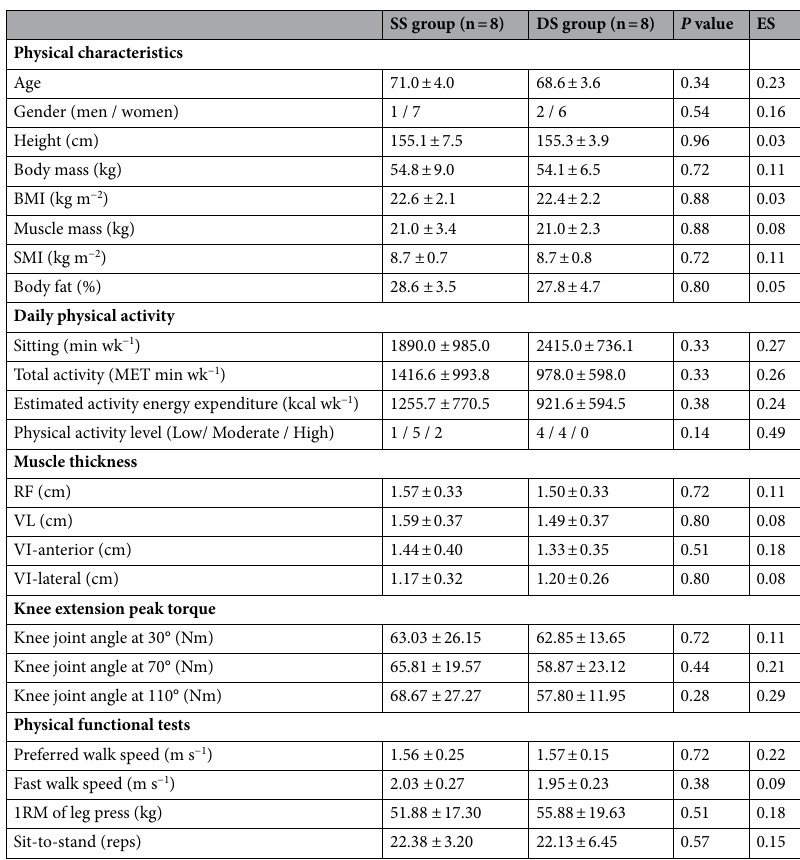
Table 1. Baseline physical characteristics parameters, daily physical activity, muscle thickness, knee extension peak torques and physical functional tests in shallow squat (SS) group and deep squat (DS) group. Values are shown as mean ± SD. ES, effect size; BMI, body mass index; SMI, skeletal muscle mass index; MET, metabolic equivalent of task; RF, rectus femoris; VL, vastus lateralis; VI, vastus intermedius; RM, repetition